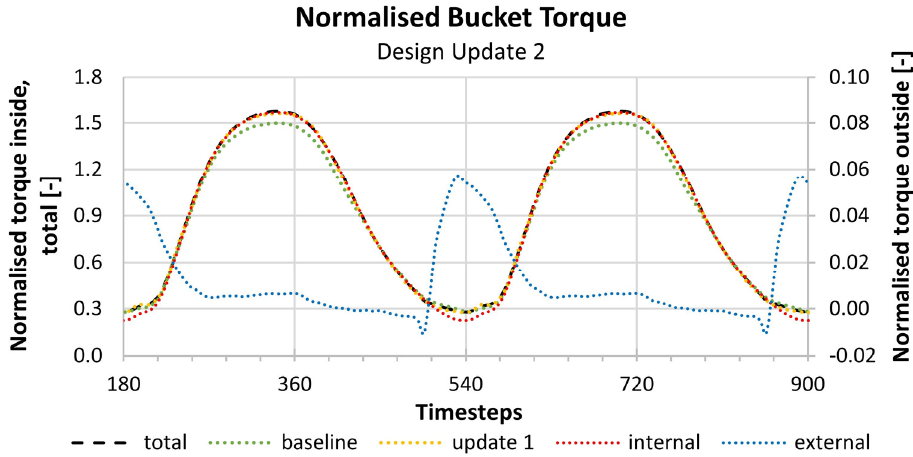
Figure 13. Normalised torque (design update 2 vs. baseline and design update 1).